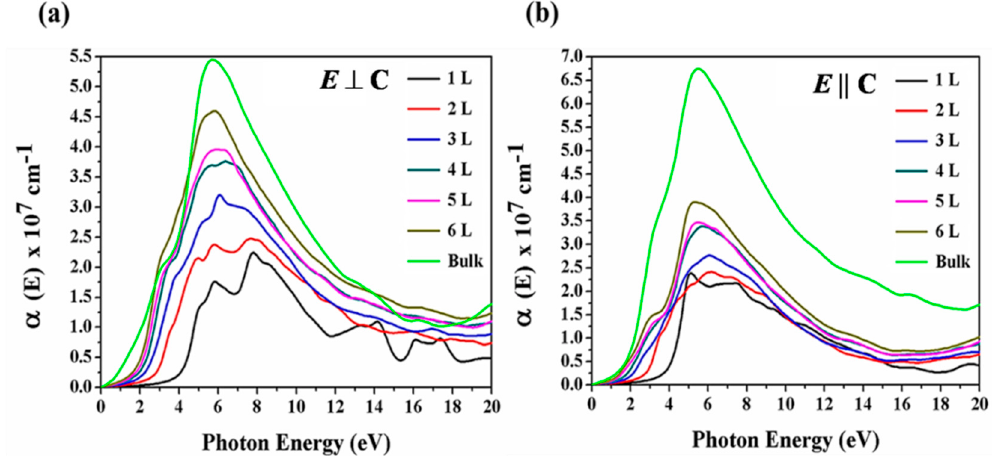
Figure 7. Calculated absorption spectra along ( a ) E ⊥ C and ( b ) E || C polarization directions of the few-layer Te and bulk Tellerium.